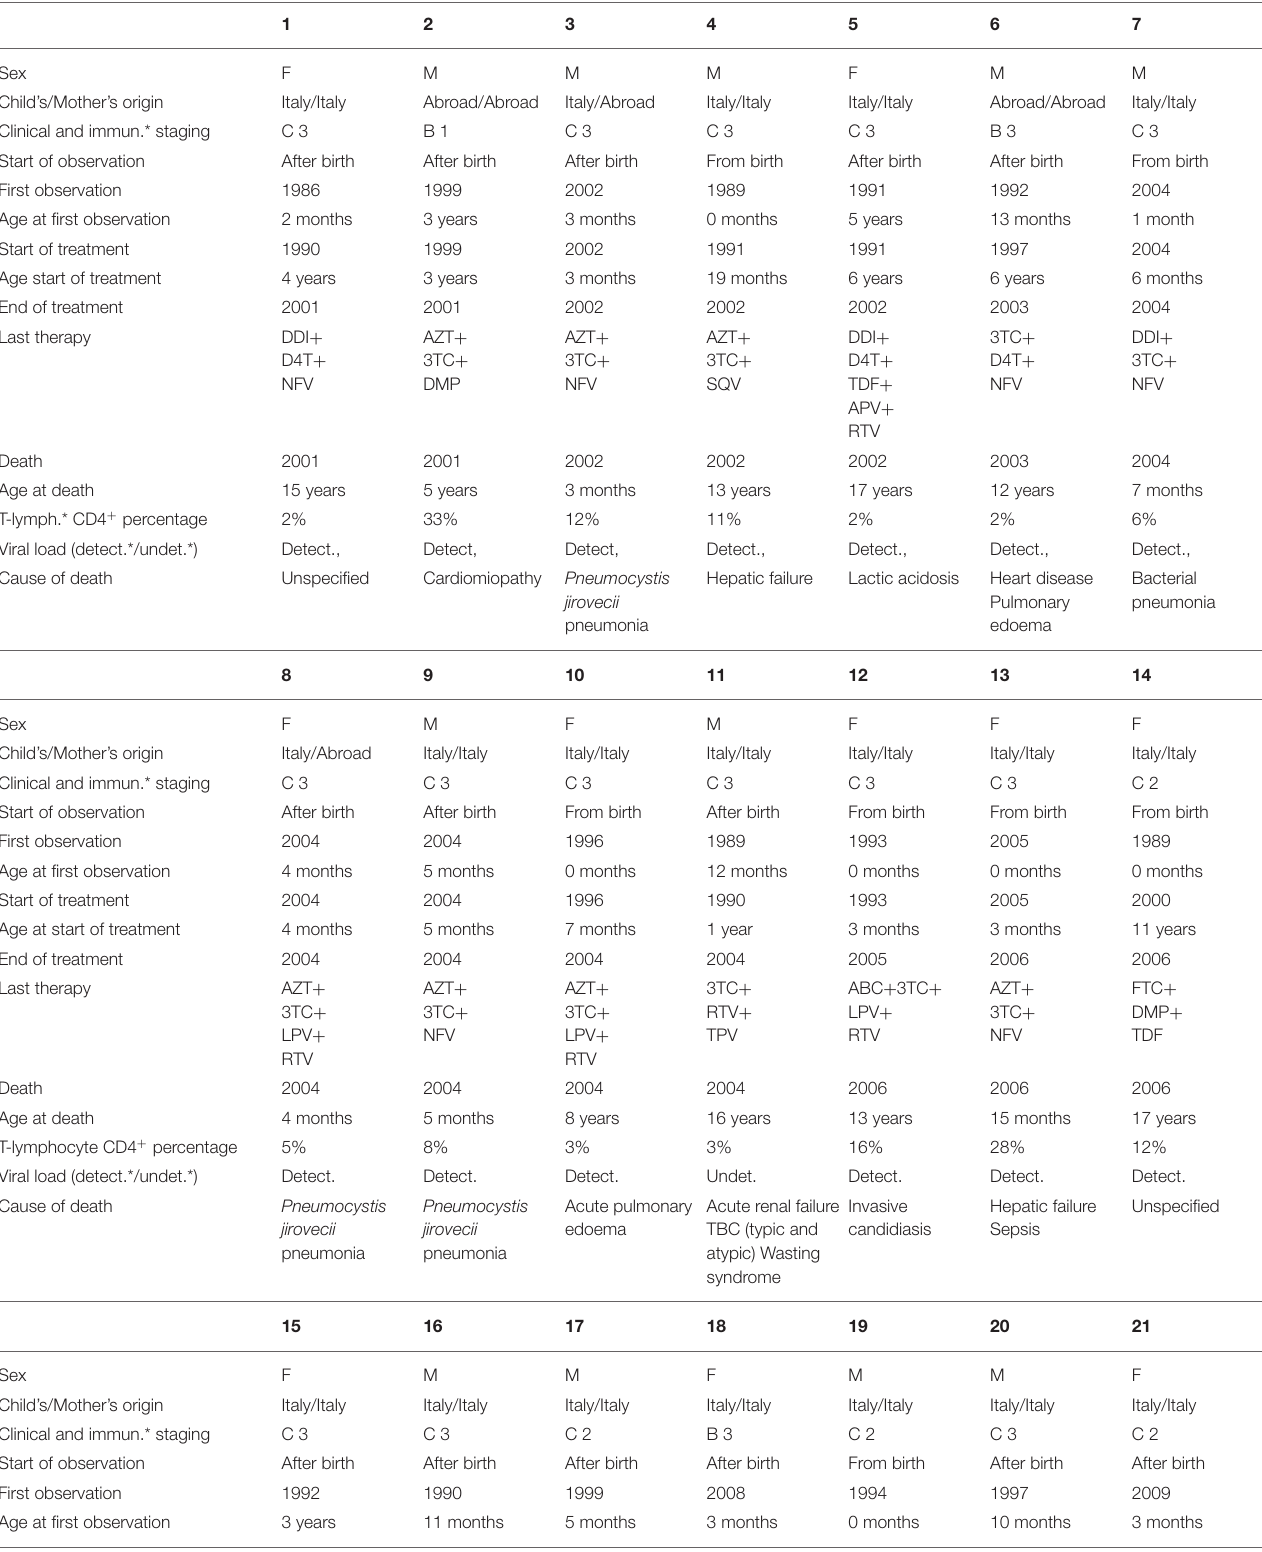
TABLE 3 | Characteristics of deaths in perinatally HIV-1 infected children (from 2001 to